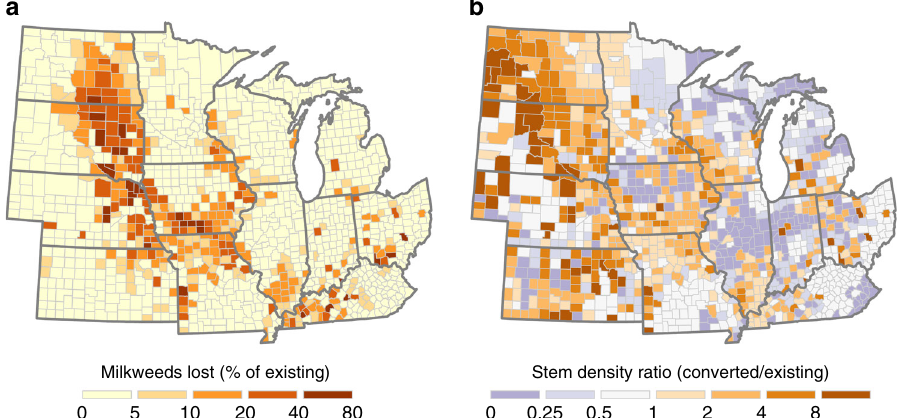
Fig. 4 Monarch habitat loss due to conversion of land to corn and soy production in the Midwest, 2008 – 16. The maps represent the number of milkweed stems lost as a proportion of those on all grasslands, shrublands, and wetlands in 2008 ( a ), and the density of milkweed stems on land subject to conversion relative to the density on existing lands in 2008 ( b ). Large losses of milkweed occurred in the region stretching from eastern North Dakota to northern Missouri — locations with high rates of cropland expansion and conversion from Conservation Reserve Program (CRP) lands, which harbor high densities of milkweed stems. Across the Midwest region, the average density of milkweed stems on land prior to conversion was over three times greater than that on average existing land. Milkweed stems provide the sole food source for Monarch butter fl y larvae.